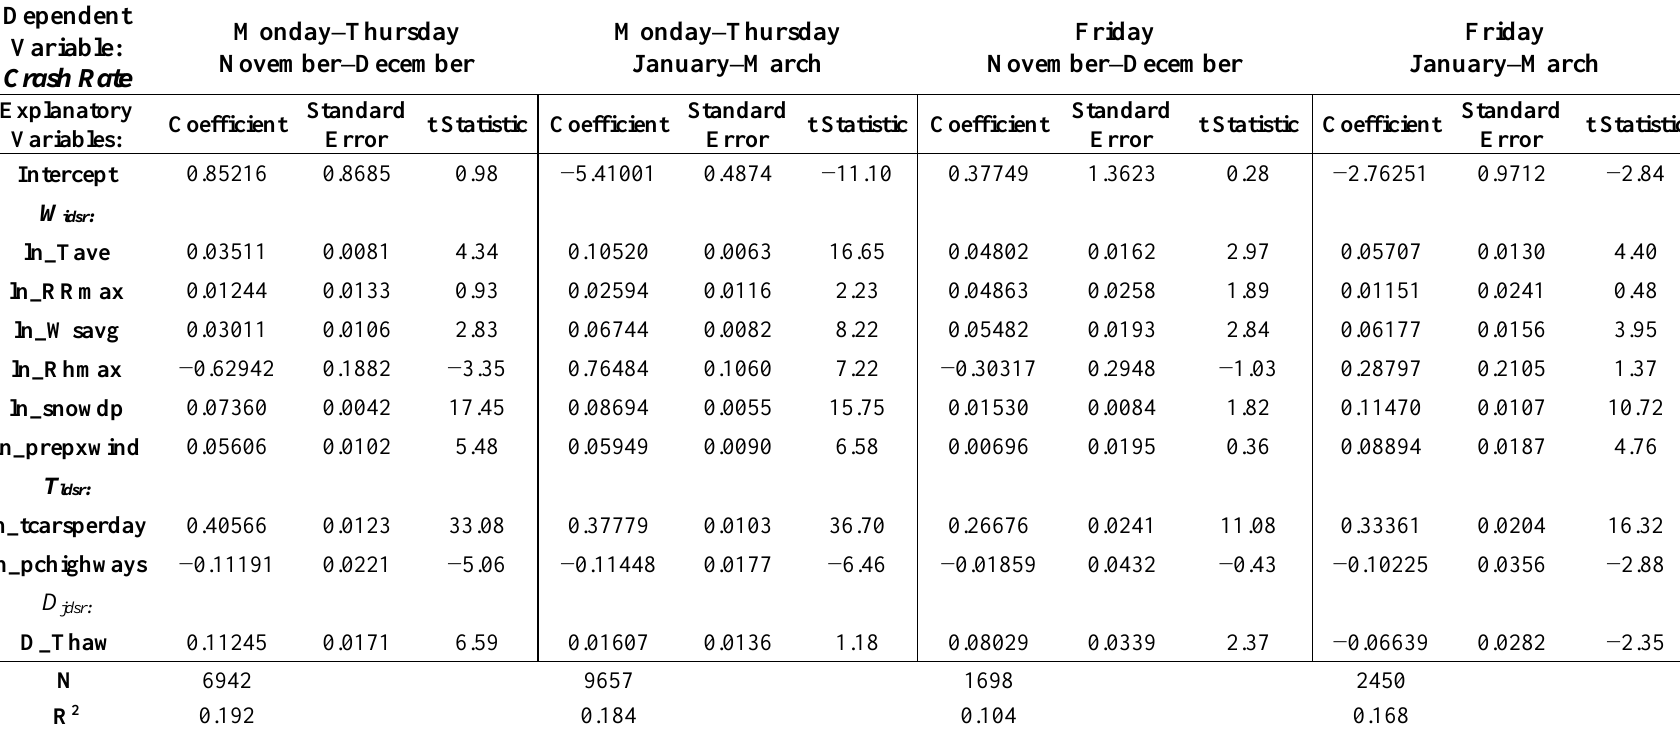
Table 2. Regression estimations for Monday–Thursday and Friday for all regions